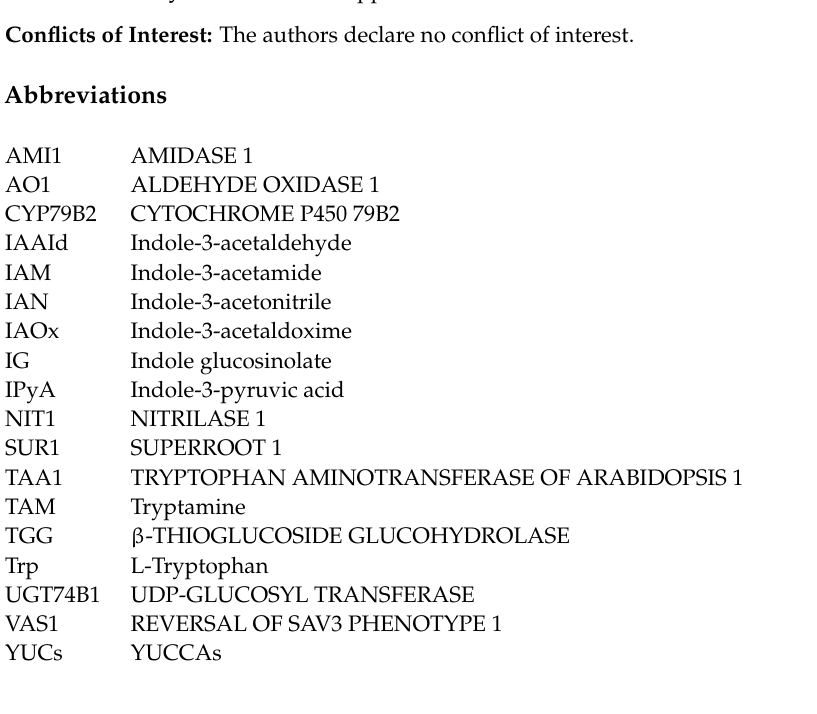
tion of studied genes, Table S2: List of primer for qRT-PCR, Table S3: Transcriptome sequence of in R. officinalis auxin pathway related